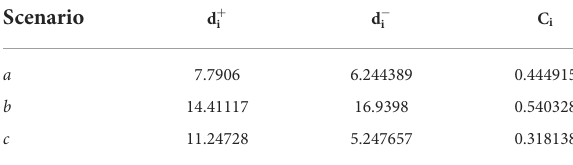
TABLE 10 Euclidean distance and relative